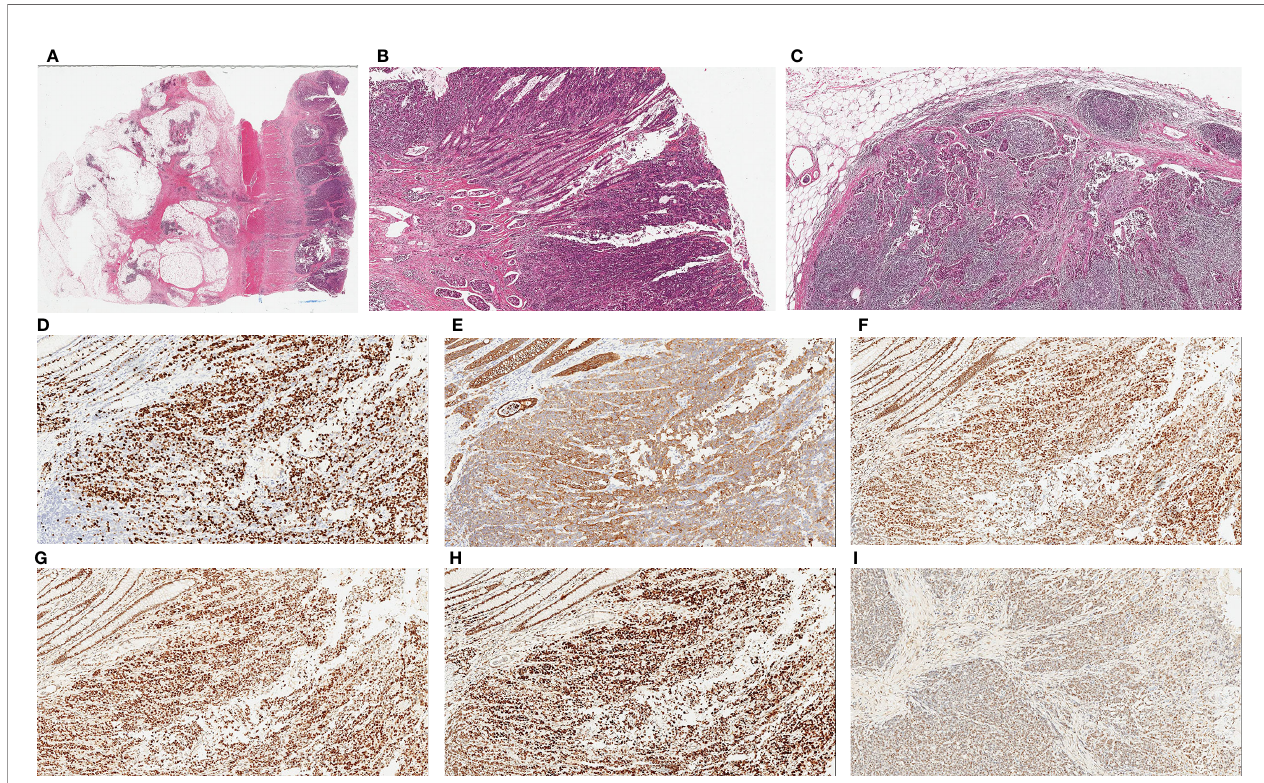
FIGURE 2 | Histopathological examination of tumor. (A) Hematoxylin and eosin (H&E) staining of colonic primary tumor shows glandular differentiation and invasion into the entire intestinal wall (×20). (B) Poorly differentiated adenocarcinoma on the surface of mucosa with multiple intravascular thrombus in submucosa, (×40). (C) Metastatic tumors can be seen in lymph node, (×40). Immunohistochemical staining of tumor cells. Ki-67 partial expression in tumor (+70%) ( D , ×100), CKpan expression in tumor ( E , ×100.), Immunostaining for MLH1 (+70%) ( F , ×100), MSH2 (+70%) ( G , ×100), MSH6 (+80%) ( H , ×100)and PMS2 (+50%) ( I , ×100) con fi rmed the tumor with pro fi cient